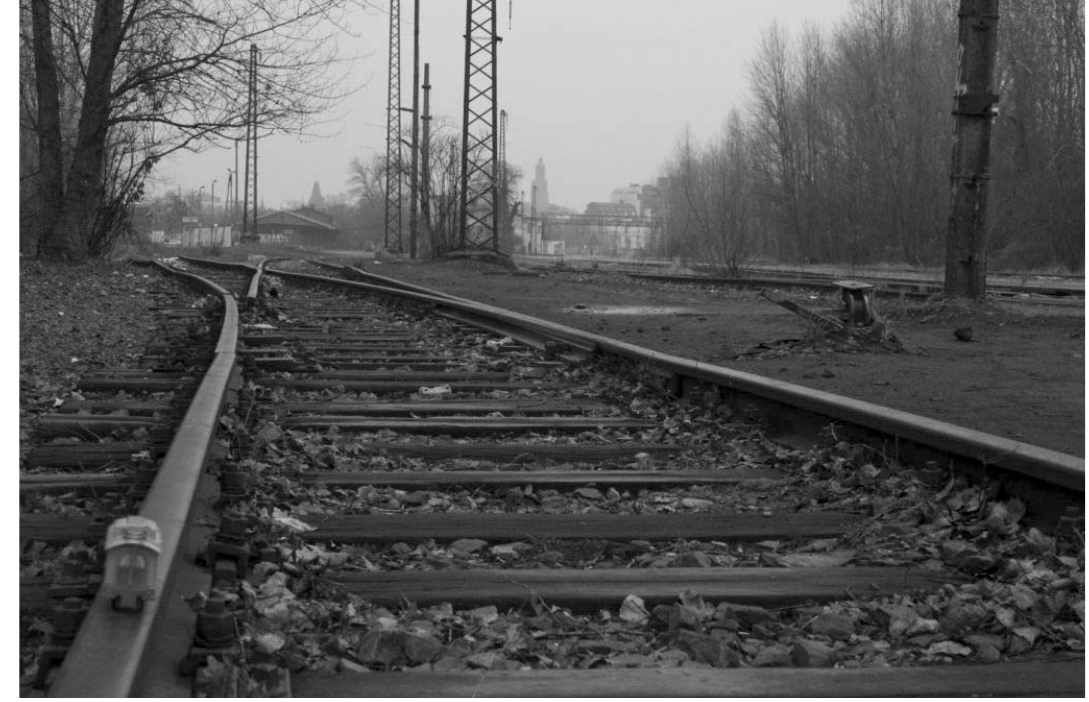
Past and presence. Nonfunctioning train station in Wroc (cid:227) aw (own